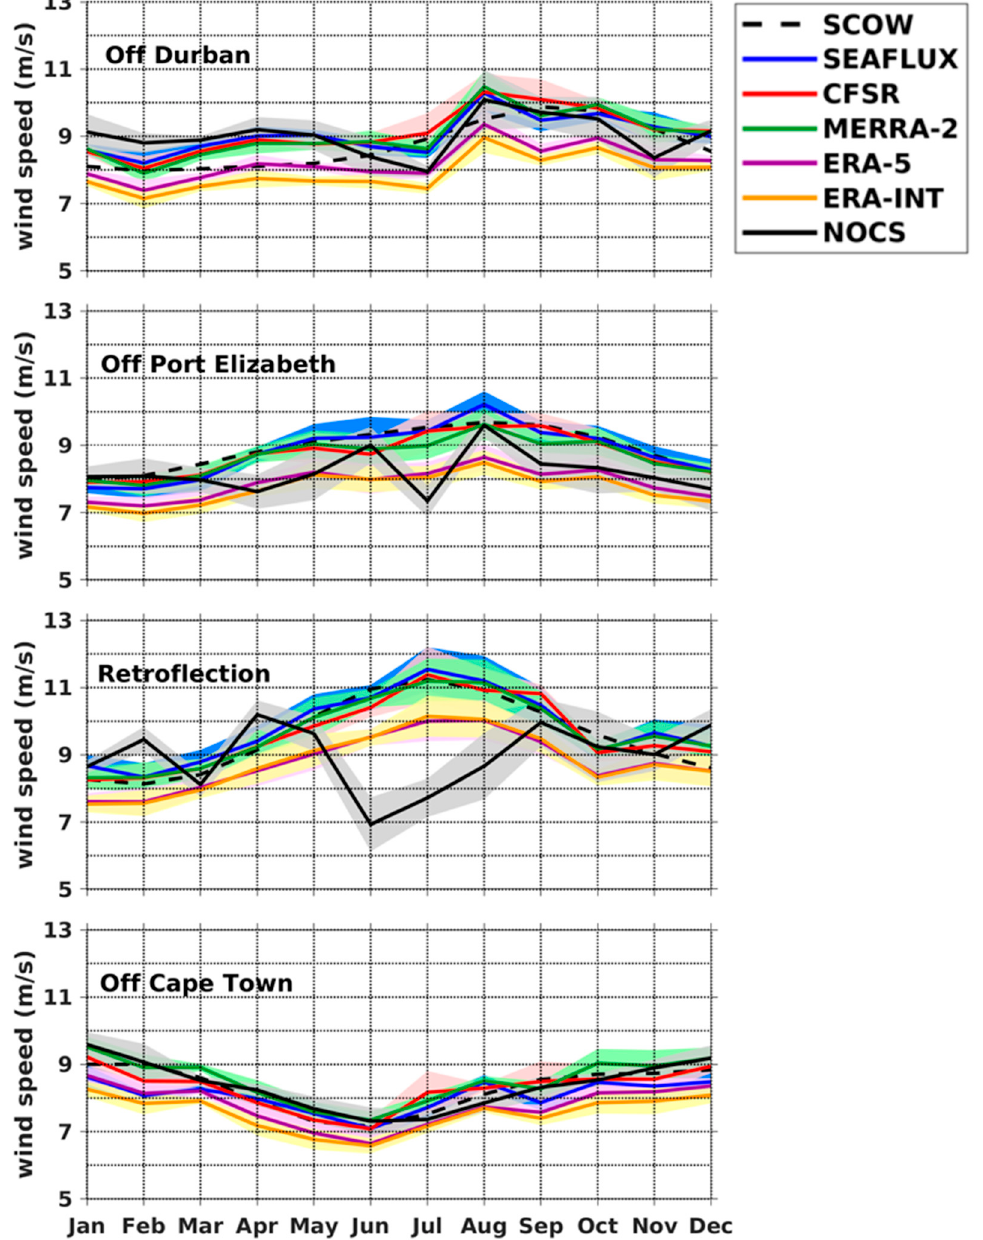
Figure 9 : Annual cycles of surface wind speed (m/s) off Durban, off Port Elizabeth, Retroflection region and off Cape Town for SCOW (black dash), SEAFLUX (blue), CFSR (red), MERRA-2 (green), ERA-5 (purple), ERA-Interim (yellow) and NOCS (black), with their respective envelopes as in Figure 3.